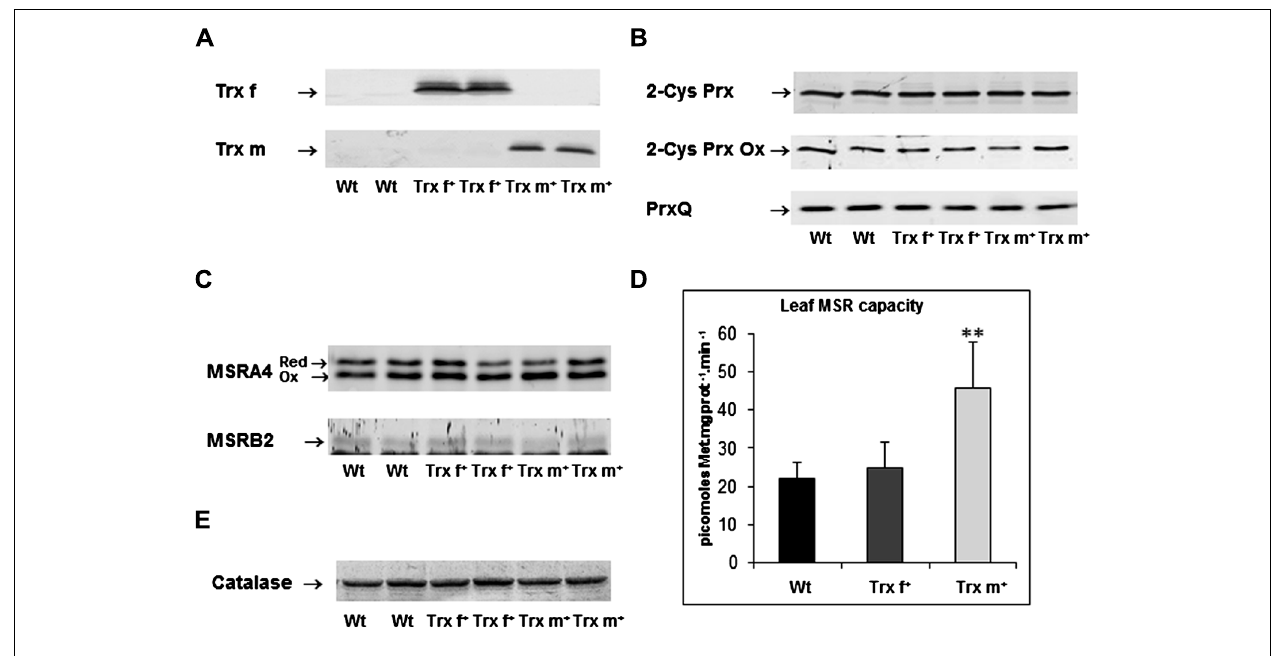
FIGURE 4 |Abundance of proteins involved in antioxidant mechanisms and leaf peptide methionine sulfoxide reductase enzymatic capacity in leaf extracts from transplastomic tobacco plants overexpressingTrx f or Trx m. (A) Western analysis ofTrx f andTrx m abundance. (B) Western analysis of the abundance and redox status of plastidial 2-Cys peroxiredoxin (2-Cys Prx) and of the abundance of peroxiredoxin Q (PrxQ). (C) Western analysis of the abundance of plastidial methionine sulfoxide reductases A4 and B2, MSRA4 and MSRB2, respectively. (D) Peptide methionine sulfoxide